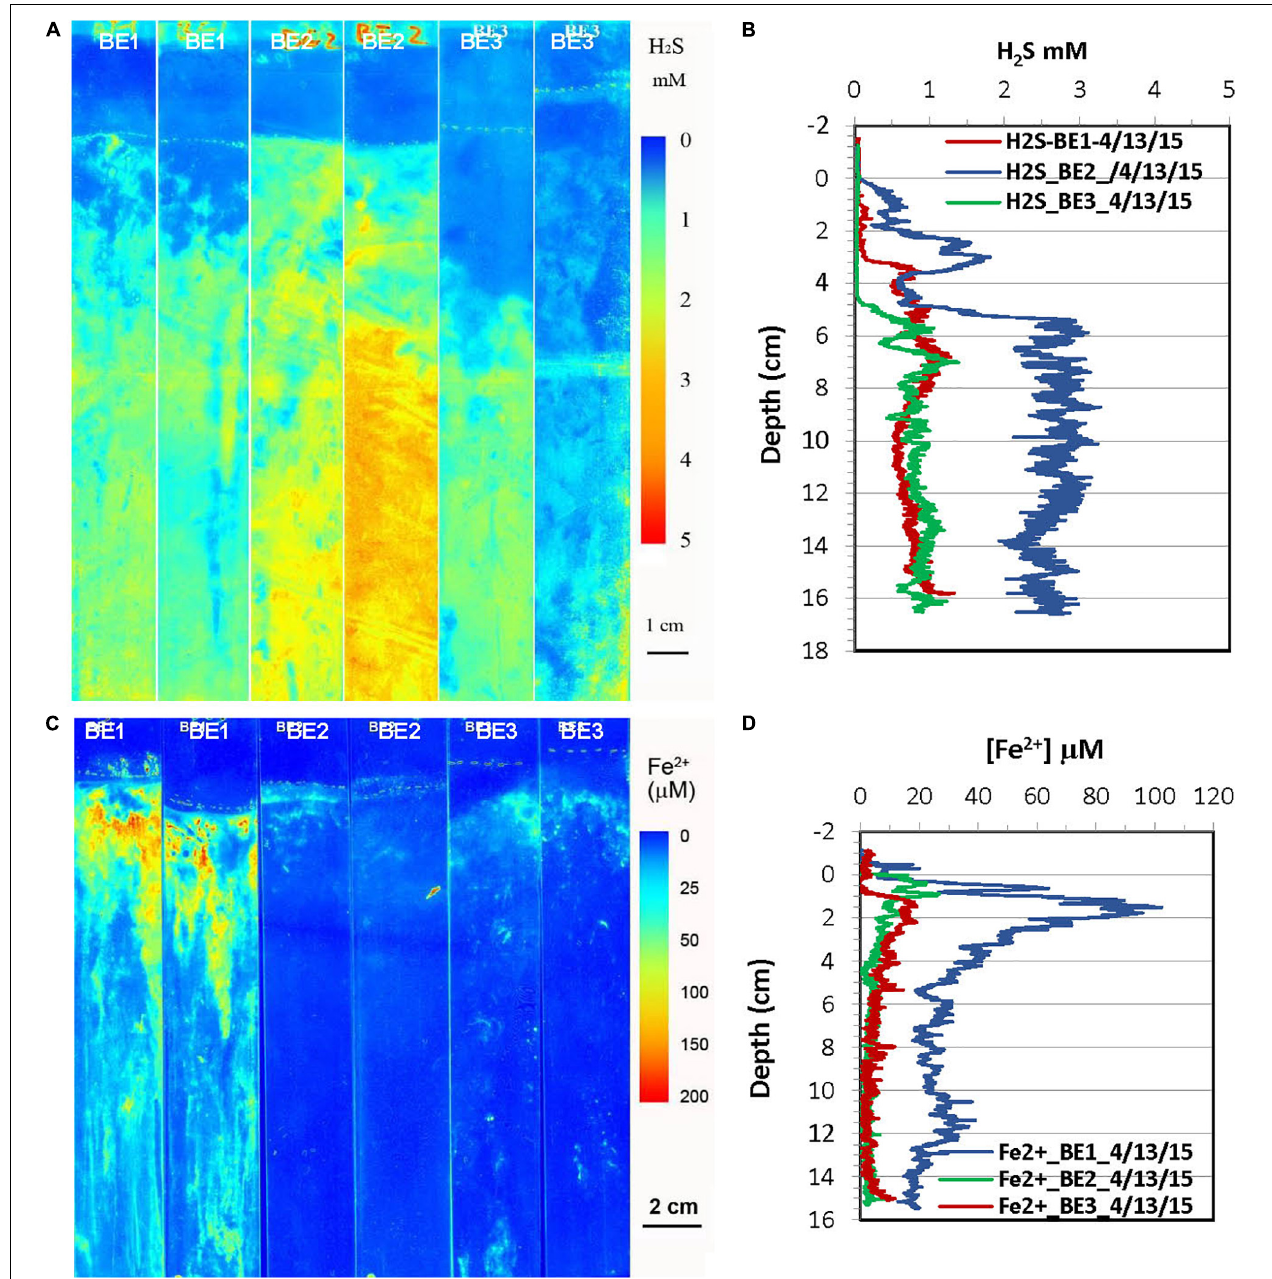
FIGURE 6 | H 2 S and dissolved Fe 2 + distribution patterns in the pore water of Big Egg (BE) marsh peats in spring 2015. (A) 2-D H 2 S distribution patterns (pseudo color) obtained by in situ measurements in sediments; white line marks the peat surface. (B) Vertical H 2 S profiles averaged from each 2-D H 2 S distribution in the panel (A) . (C) 2-D Fe 2 + distribution patterns obtained by in situ deployments, white line marks the peat surface. (D) Vertical Fe 2 + profiles averaged from each 2-D Fe 2 + distributions in the panel (C) .